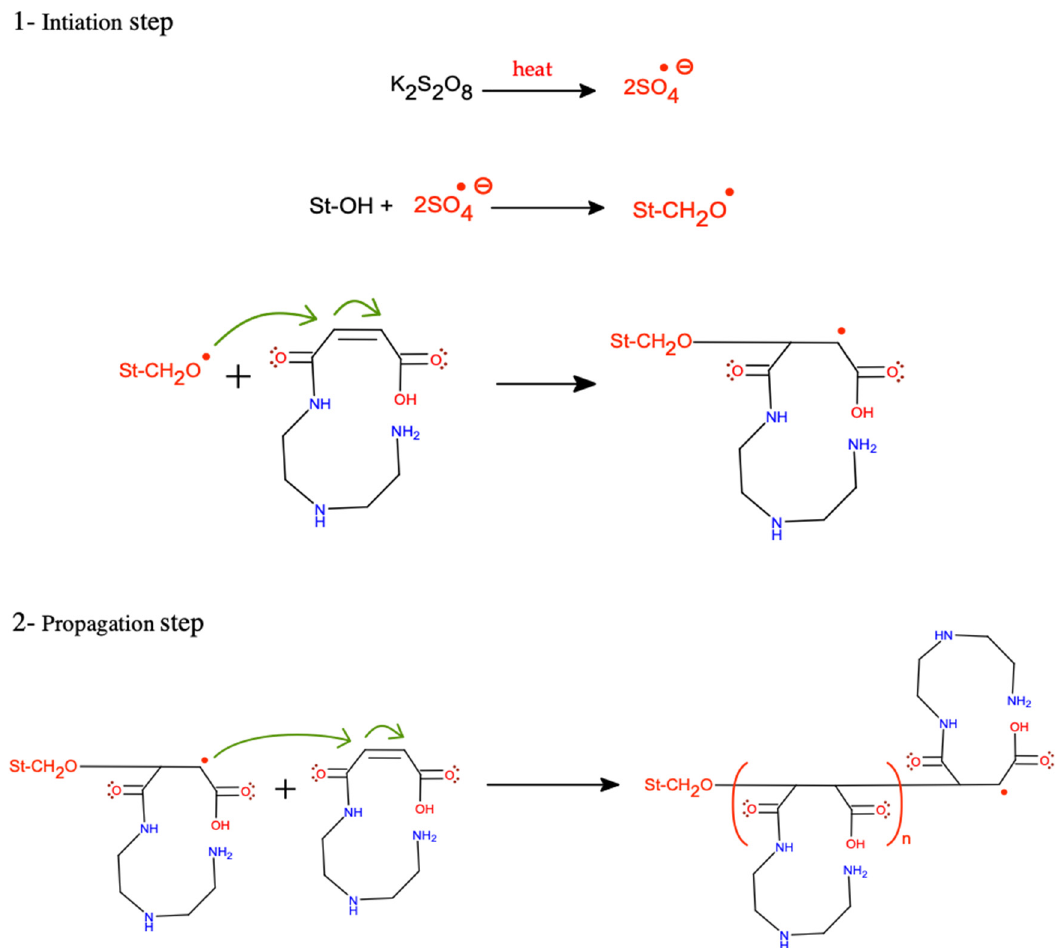
Figure 3. Suggested graft copolymerization mechanism of St-g-(MA-DETA), where St-OH is native starch, and St-CH 2 O * is carbon number 6 in the glucopyranose